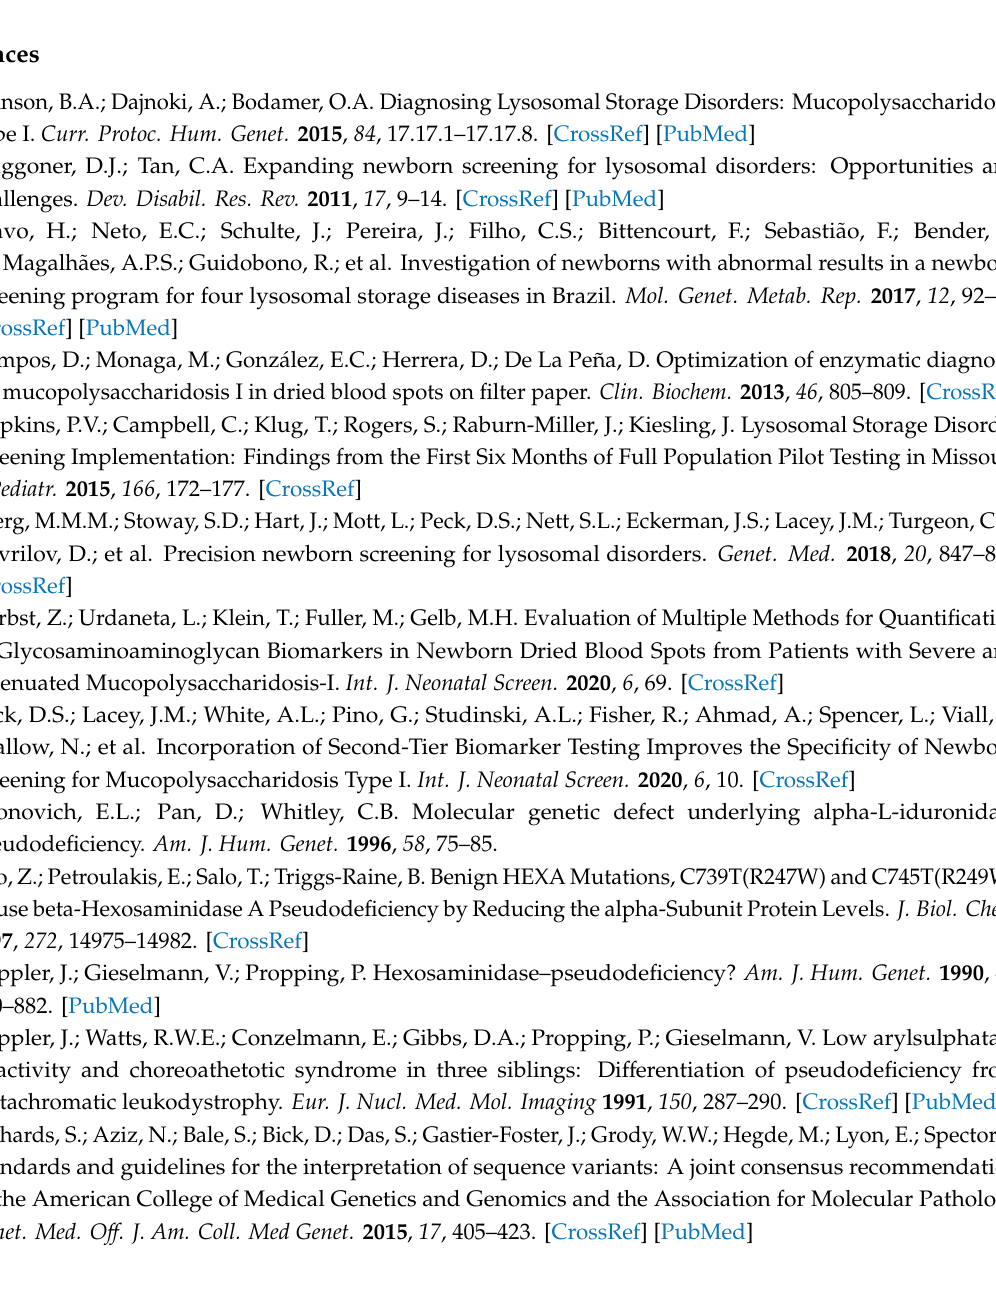
Supplementary Figure S1: Standard curve for α -iduronidase activity in WT clone 1B3, Figure S2: Activity of α -iduronidase was determined in several clones using a higher lysate concentration for more accurate stratification of residual